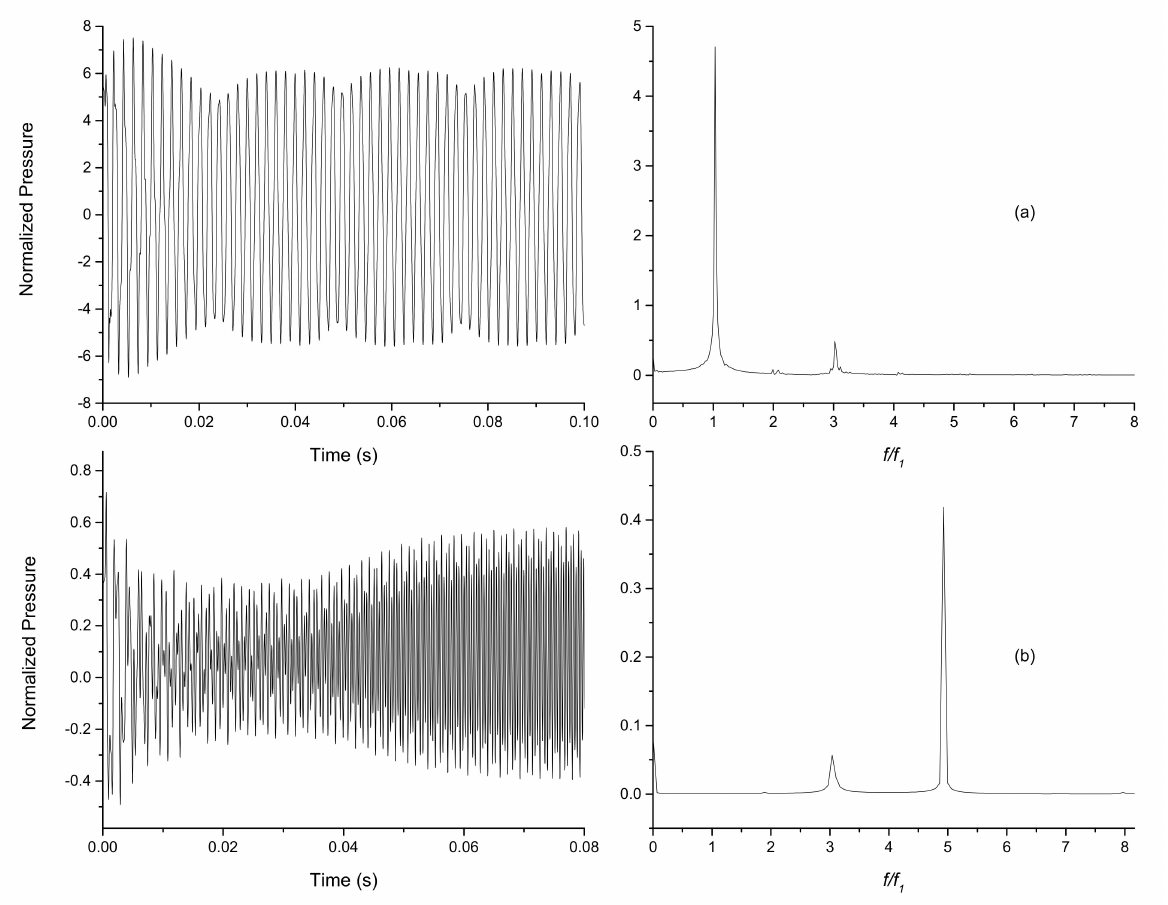
Figure 11. The beating phenomenon at the flow velocity of v = 70 m/s, ( a ) α = 60 ◦ , ( b ) α = 90 ◦